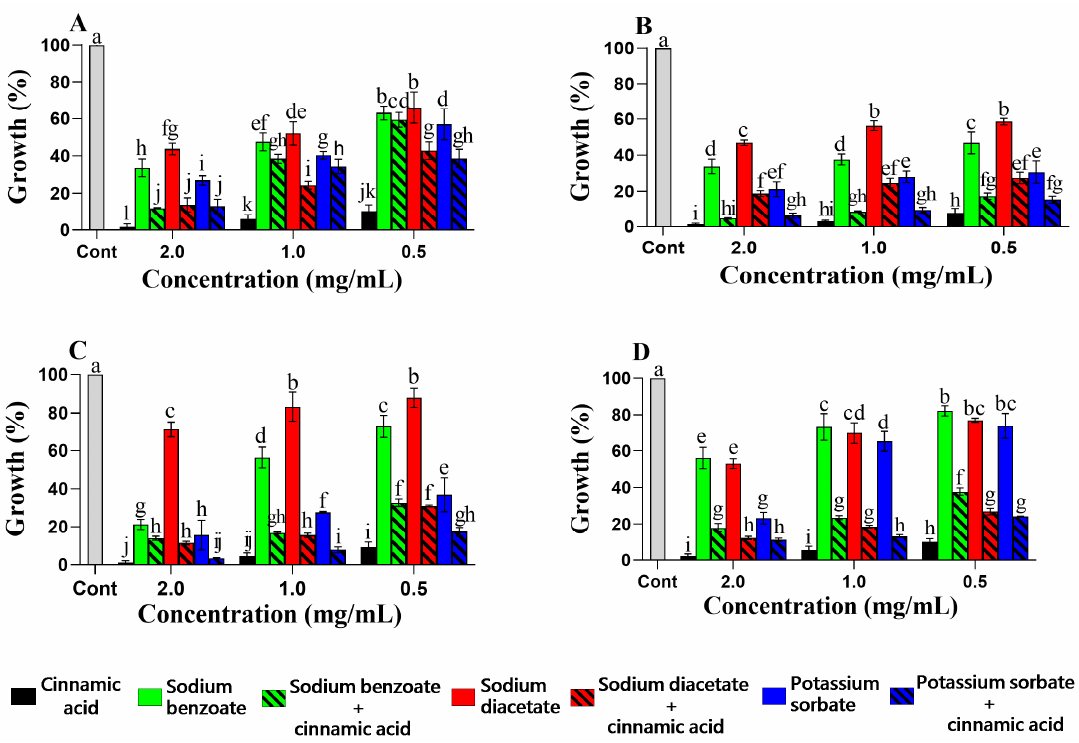
Figure 1. E ff ect of the antimicrobial agents on planktonic growth of D. hansenii SZMC 8045Mo ( A ), W. anomalus SZMC 8061Mo ( B ), S. pombe SZMC 1280 ( C ), and S. cerevisiae SZMC 1279 ( D ) when the vanillin and synthetic agents were used alone or in combination in equal proportions. The control (Cont.) represents growth in the absence of the compounds. The results are the mean percent growth relative to the control; error bars represent standard deviation. The di ff erent le tt ers above the col- umns indicate statistically signi fi cant di ff erences ( p < 0.05).